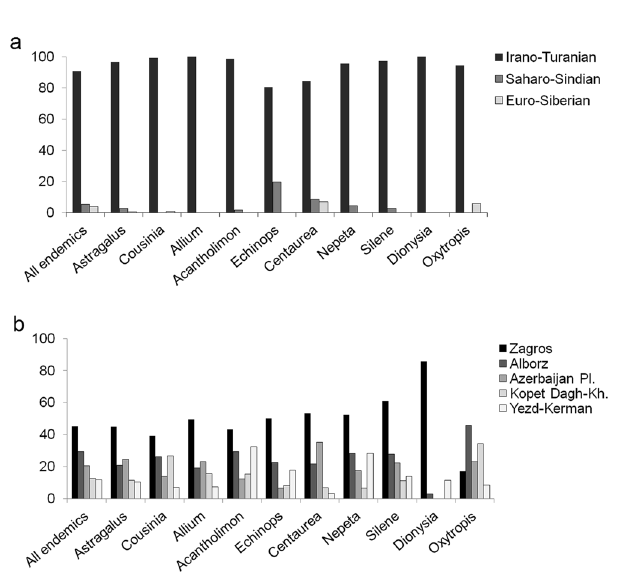
Figure 4. Distribution of endemic vascular plant species (total and in the 10 most endemic-rich genera) across ( a ) phytogeographical regions and ( b ) areas of